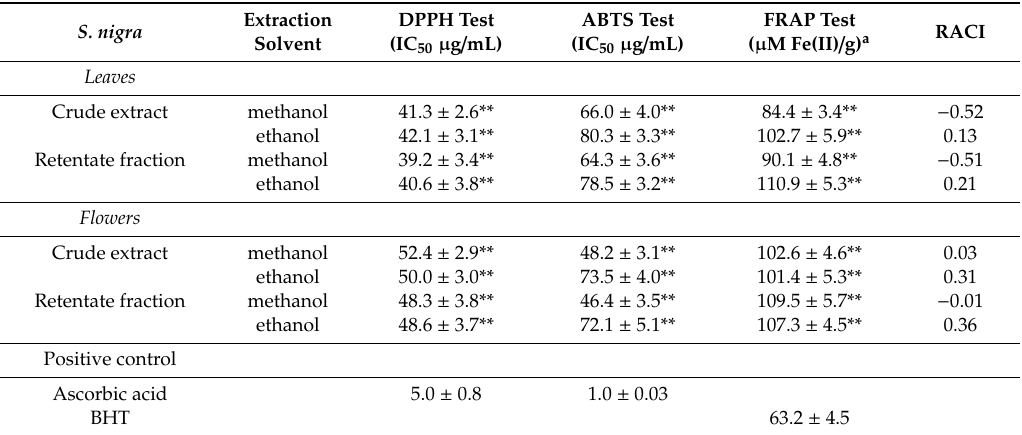
Table 4. In vitro antioxidant activity of S. nigra leaf and floral